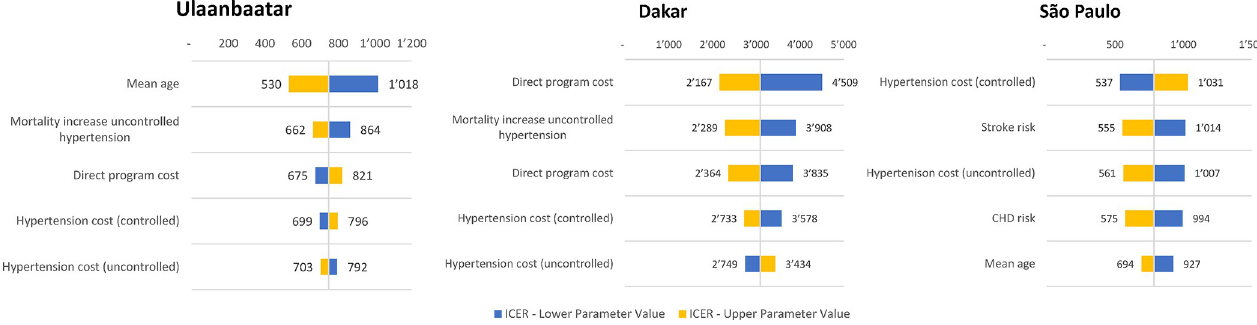
Fig 4. One-way sensitivity analysis of cost effectiveness across three cities. Each parameter was varied independently by 10% and ICERs calculated.